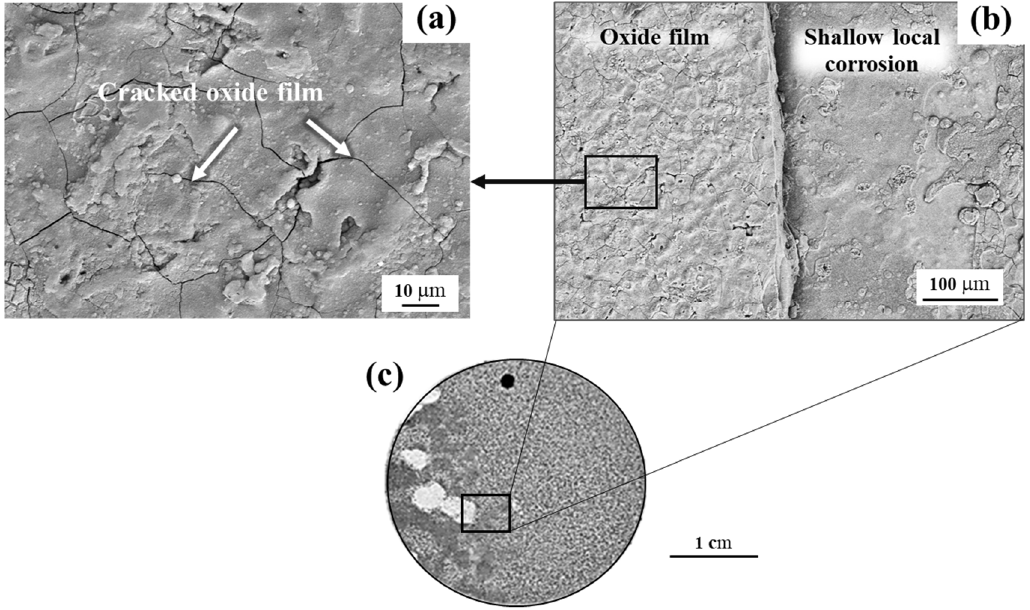
Figure 12. Corroded area of a 2-N sample after salt spray testing: SEM images in ( a , b ) from the inset in the optical micrograph in ( c ).